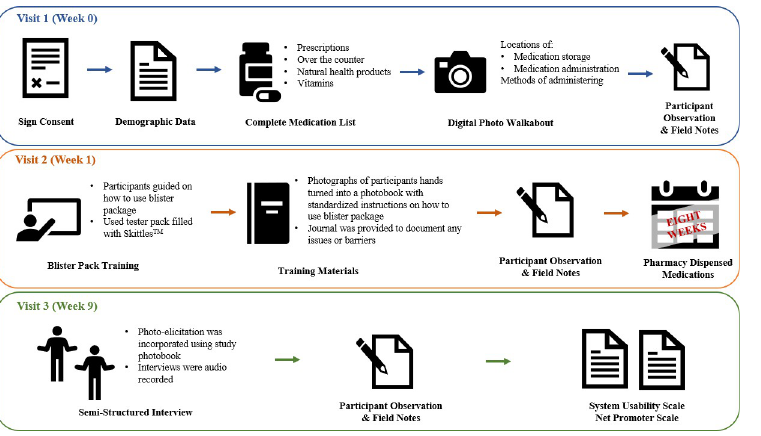
Fig 3. Details of study